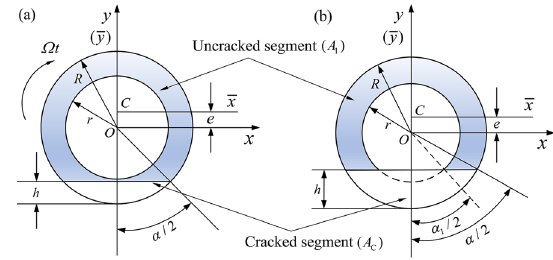
Figure 2 Cross-section diagram of hollow shaft crack: ( a ) Non-penetrating crack, ( b ) Passthrough crack. The dashed area represents the uncracked